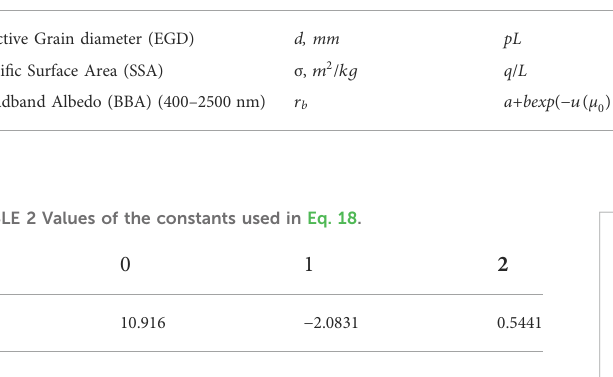
TABLE 1 The relationships of various snow parameters with the value of the effective absorption length L for the case of clean snow (case 1 snow). Quantity